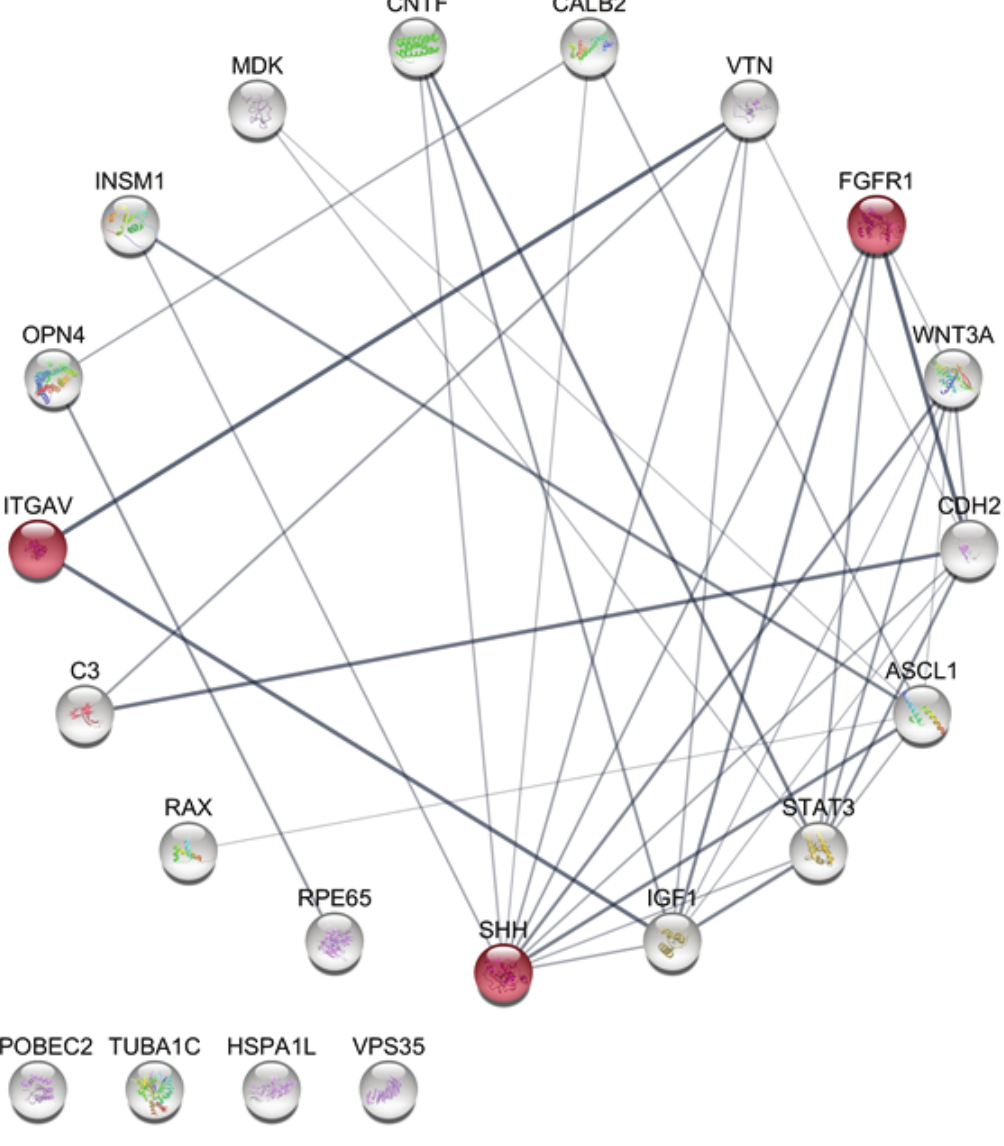
Figure 3. Angiogenesis involved proteins in retina regeneration, presented in a degree-sorted circular layout of the PPI network performed by STRING App in Cytoscape 3.7.2. Each circle provides a schematic drawing of protein structure. The colors are set randomly, and the connection line’s thickness illustrates the relation of power. Also, a thicker line presents much more evidence and documents to approve the